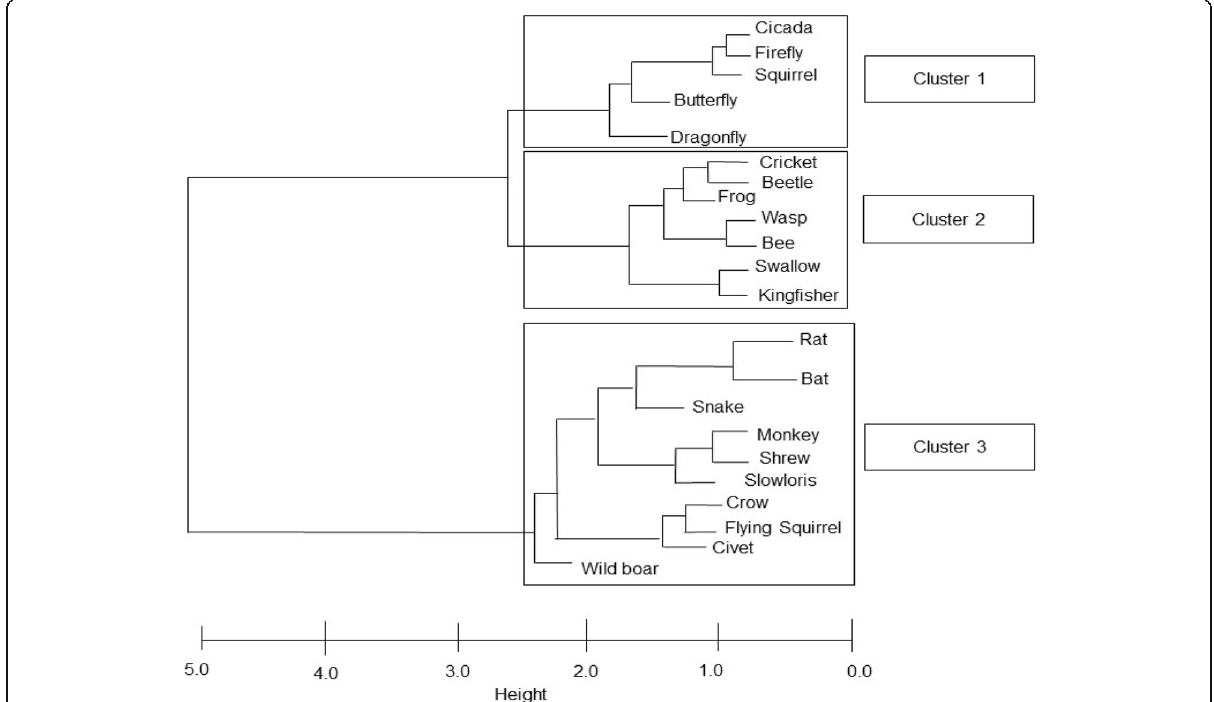
Fig. 3 Ward ’ s dendrogram of a hierarchical cluster analysis conducted on 22 animal